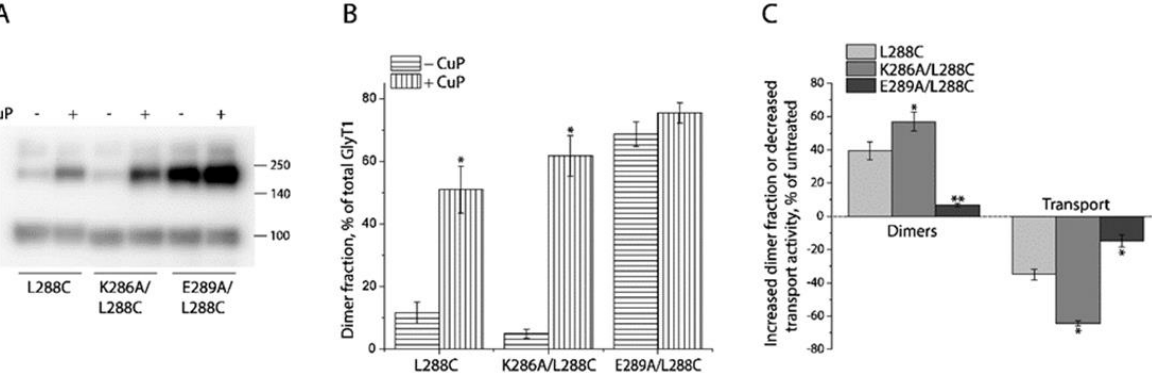
Figure 5. Influence of ion pair mutations on CuP cross-linking and transport activity of L288C. ( A ) A representative immunoblot of ion pair mutants with or without CuP treatment. HEK293 cells stably expressing GlyT1 L288C, K286A/L288C, or E289A/L288C were treated with 10 µ M CuP at 22 ◦ C for 15 min. After quenching, GlyT1 in cell lysates was detected by immunoblot analysis as described under “Materials and Methods”. ( B ) Quantification of dimer fractions of L288C, K286A/L288C, and E289A/L288C with or without CuP treatment. Dimer fraction was expressed as a percentage of fully glycosylated dimers in total GlyT1. Results are presented as mean ± SEM averaged from three independent experiments. * p < 0.05 compared to each mutant without CuP treatment. ( C ) CuP-induced increase in dimer fraction and decrease in transport activity. Immunoblot analysis and [ 3 H]glycine uptake were parallelly performed to examine CuP-induced changes in both dimer fraction and transport activity with HEK293 cells stably expressing GlyT1 L288C, K286A/L288C, and E289A/L288C as described under “Materials and Methods”. All results are presented as mean ± SEM averaged from at least three independent experiments. * p < 0.05; ** p < 0.01 compared to the background construct,